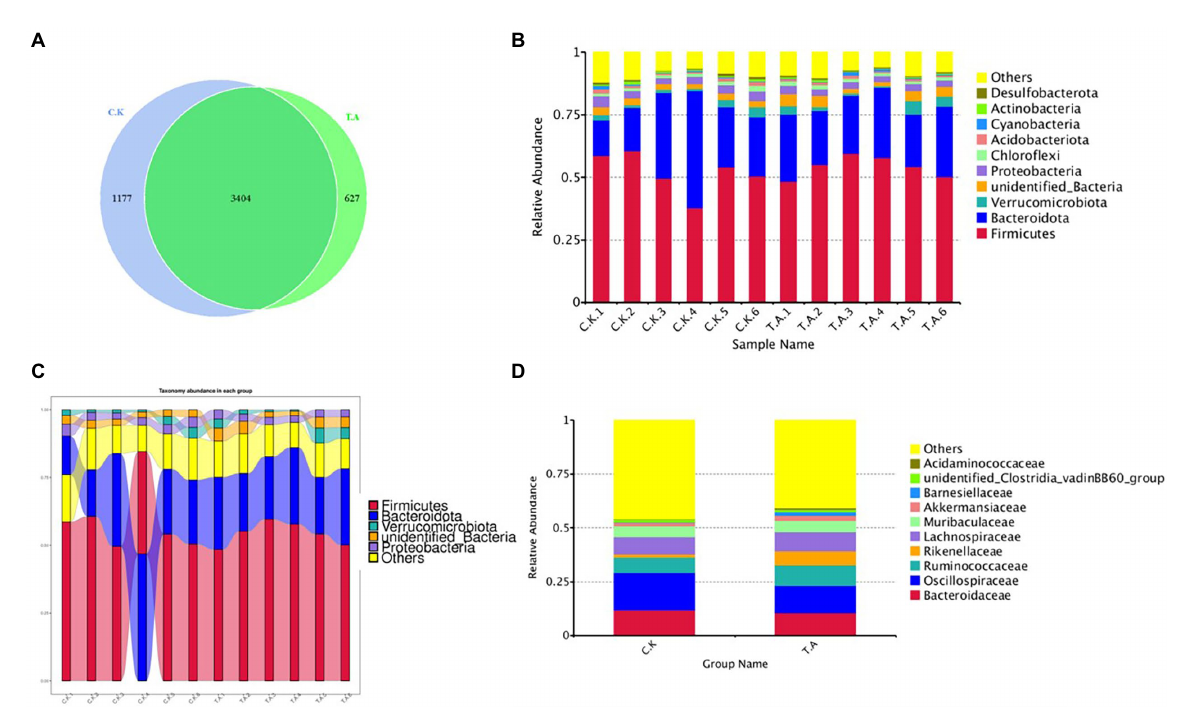
FIGURE 1 Analysis of the microbial diversity composition of rabbits based on 16SRNA sequencing technology. (A) Venn diagram of cecal microbial diversity in two groups. (B) Bar graph of the relative abundance of the top10 species. (C) Analysis of microbial abundance of meat rabbits on phylum classification. (D) Sankey of the microbial abundance of control and LNT